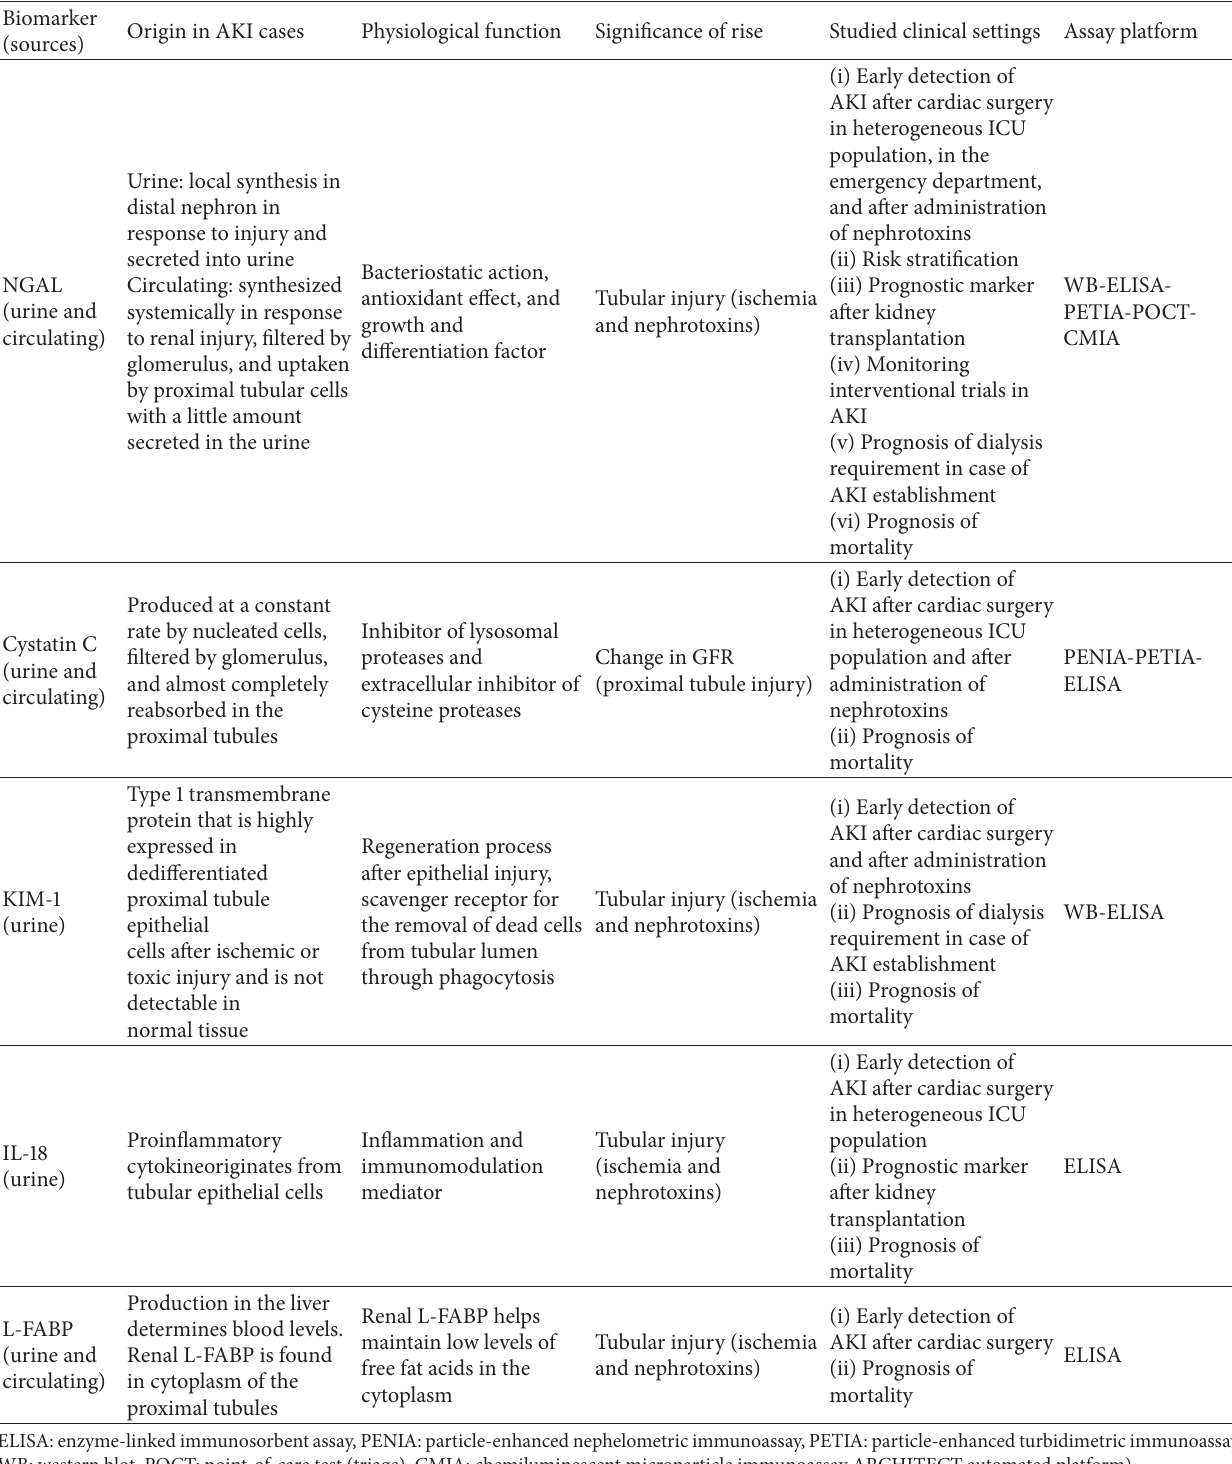
Table 3: Properties of renal